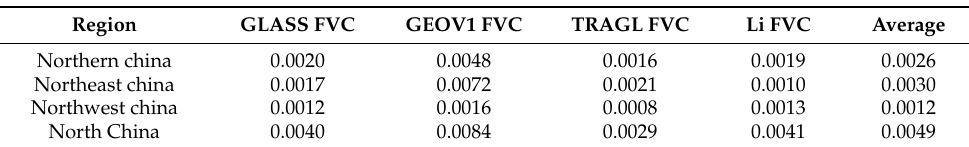
Table 2. Mean variation trend values of annual average maximum FVC seen by four data sets for 2001–2012.